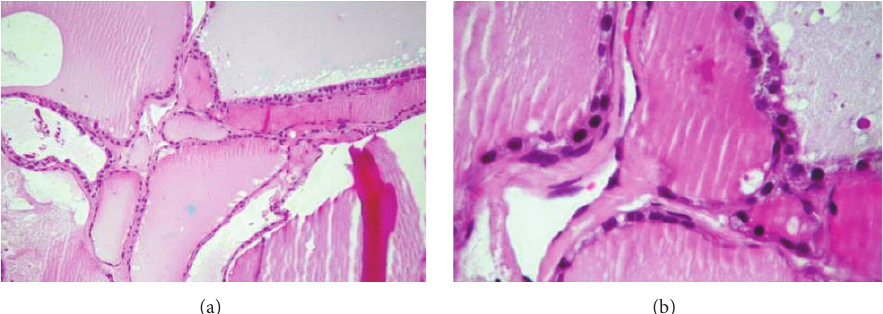
Figure 6: (a) The slide shows several follicular spaces with colloid content in their interior. (b) Colloid content surrounded by thyroid luminal epithelial cells classified as simple cuboidal glandular